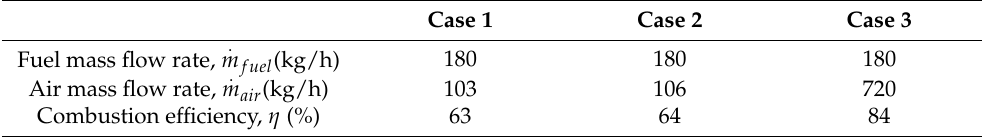
Table 5. Comparison of the fuel and oxygen mass flow rates and combustion efficiency.